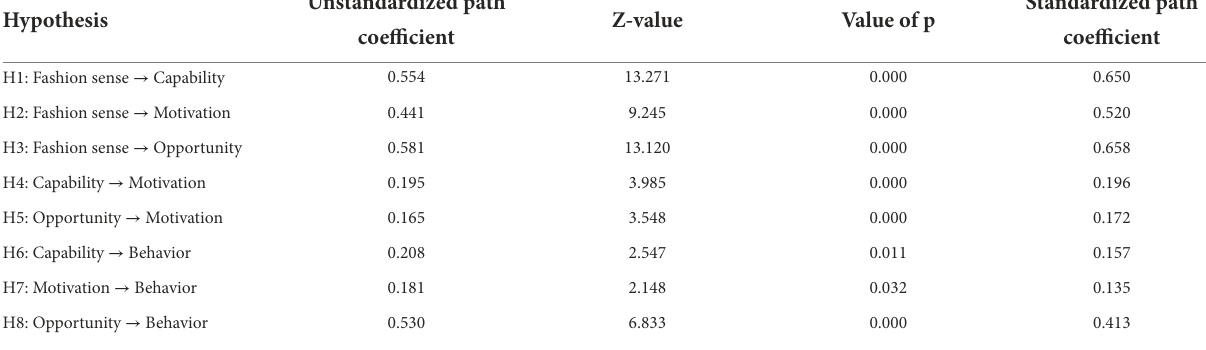
TABLE 7 Hypothesis testing